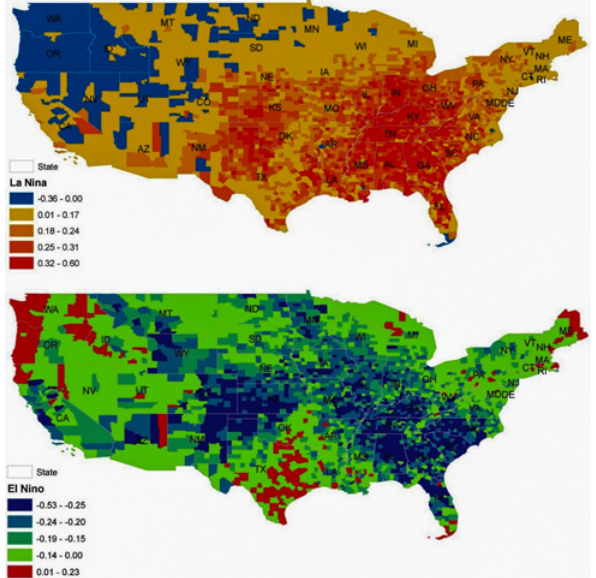
Fig 2. Relative percent change in monthly total extreme heat events for La Ni ñ a and El Ni ñ o months in 1960 – 2010 compared to ENSO Neutral months, adjusted for seasonal and 2006 land-use classification